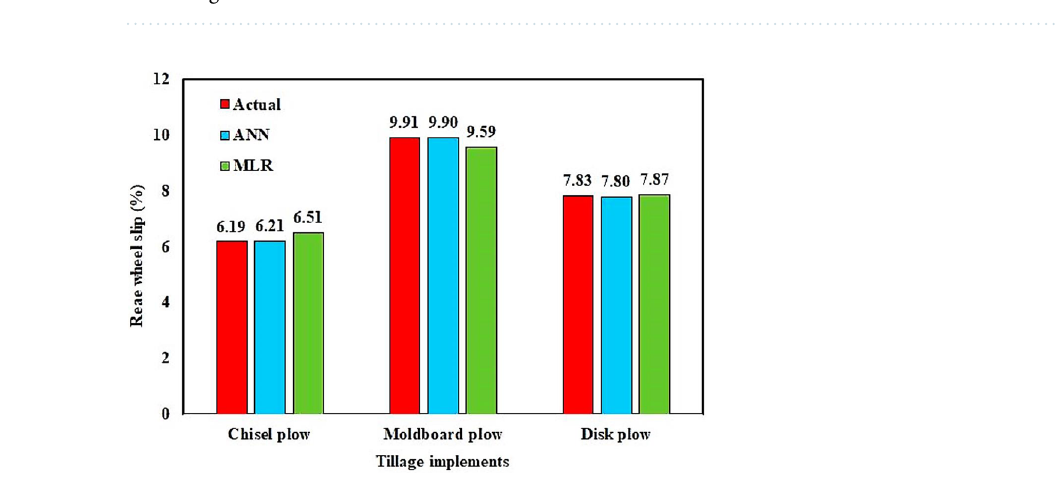
Figure 12. Variations of the observed and ANN-predicted tractor rear wheel slip during tillage operation using the testing data set.